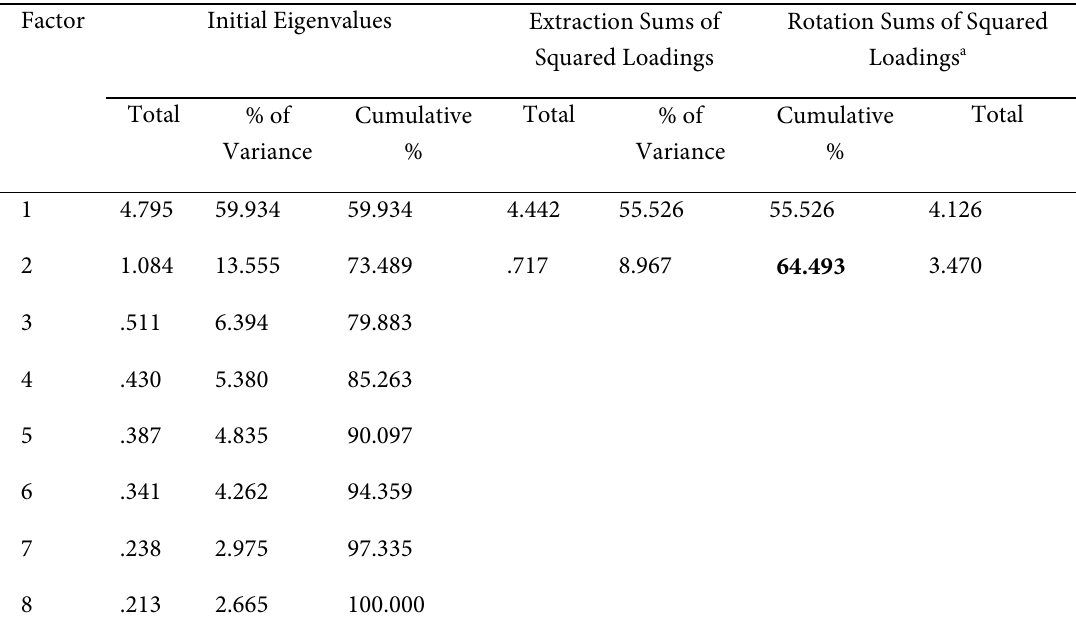
Table 2: Total Variance Explained - eHealth Literacy Factor Initial Eigenvalues Extraction Sums of